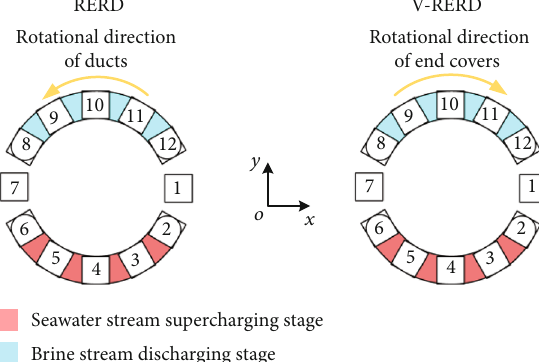
Figure 5: Working stages and duct positions.